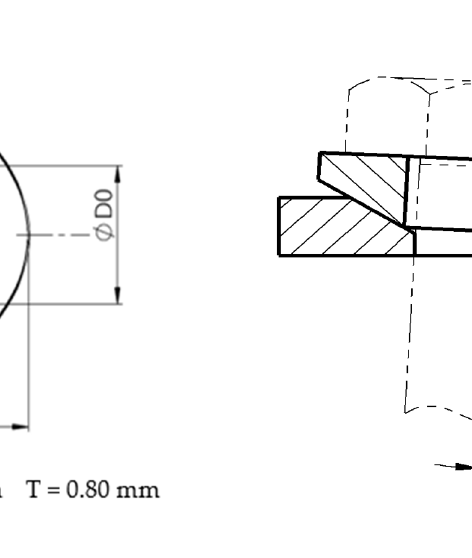
Figure 2. Constructive types of elements used to make tools: ( a )—corrugated spring washer—for tool V02; ( b )—spherical washer—conical base—for tool V03.